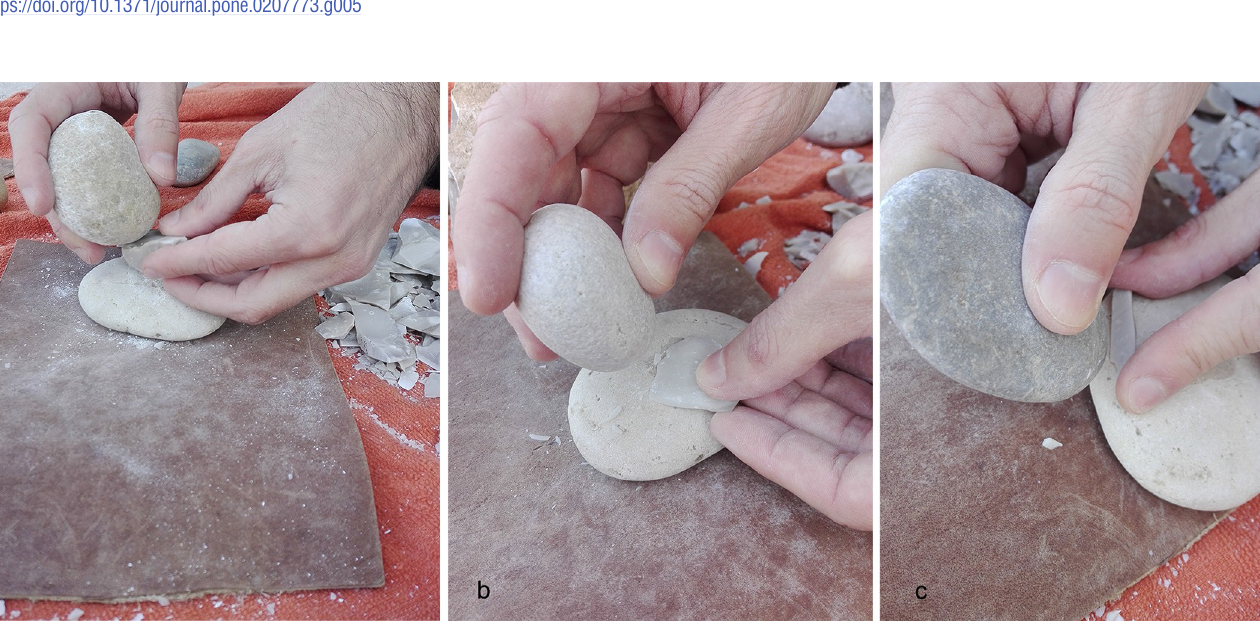
PLOS ONE | https://doi.org/10.1371/journal.pone.0207773 December12,